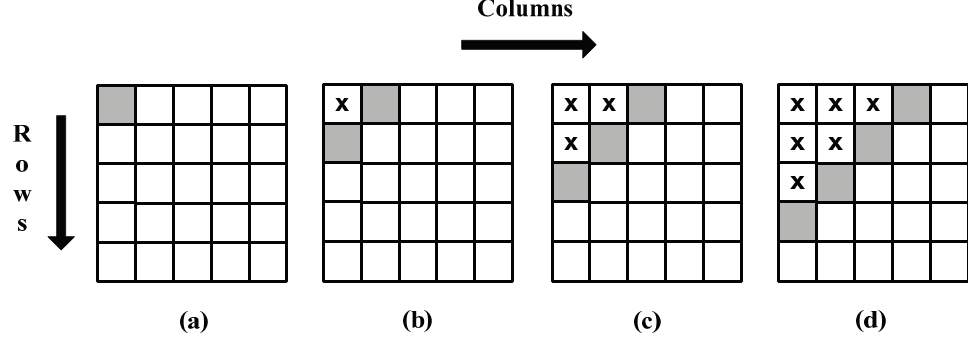
Figure 3. Delayed row computation using the Viola-Jones recursive equations.